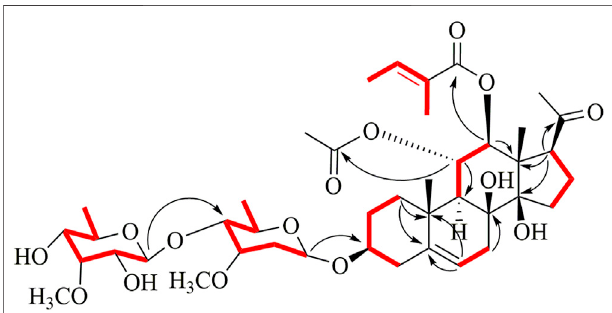
FIGURE 2 | Key HMBC and 1 H- 1 H COSY correlations of compound